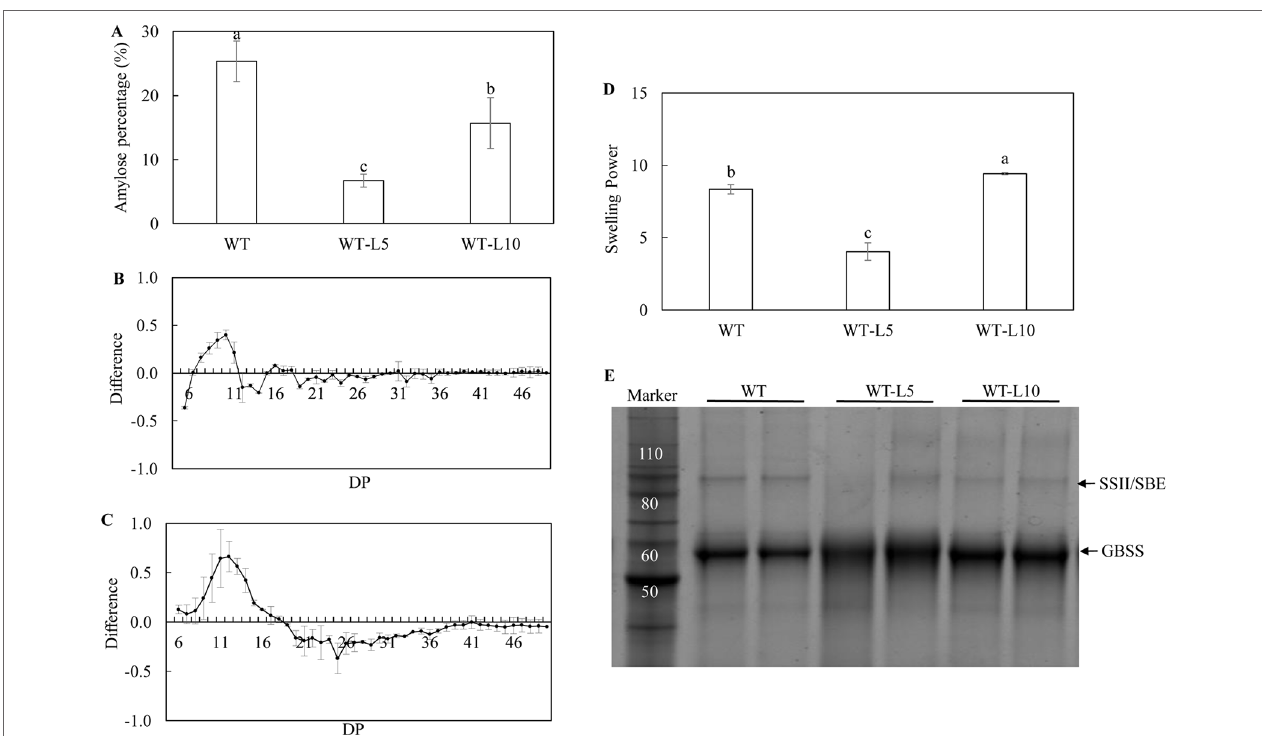
FigURE 4 | Analysis of the starch properties in the mature potato tubers. (A) Amylose content; (B) Chain length distribution (CLD) variation in debranched starch samples of WT-L5 relative to WT; (c) CLD variation in debranched starch samples of WT-L10 relative to WT; The CLD was reflected as the degree of polymerization (DP), each mark above the horizontal axis corresponds to the difference of a chain length in mole percentage. The error bars represent the standard errors, and the difference value was obtained by subtracting the CLD of WT from the two selected RNAi lines, respectively. (D) Swelling power of potato flour; (E) SDS-PAGE of potato starch granule bound proteins (GBPs). The data represent the mean values ± SD of three biological replicates. Letters (a, b, c) above the bars are based on least significant difference (LSD), bars marked with different letters are statistically significantly different at P <